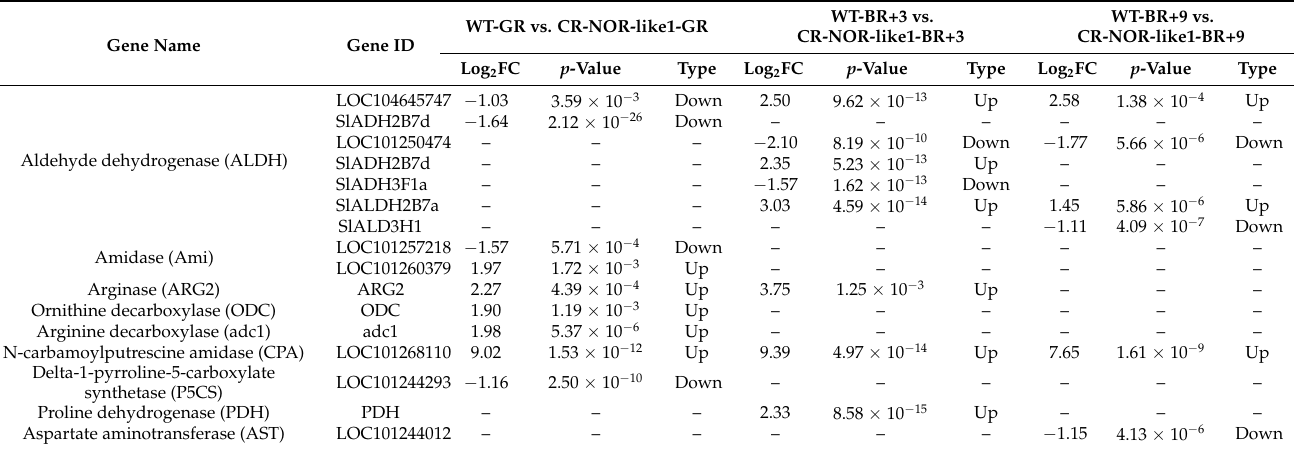
Table 1. List of DEGs related to